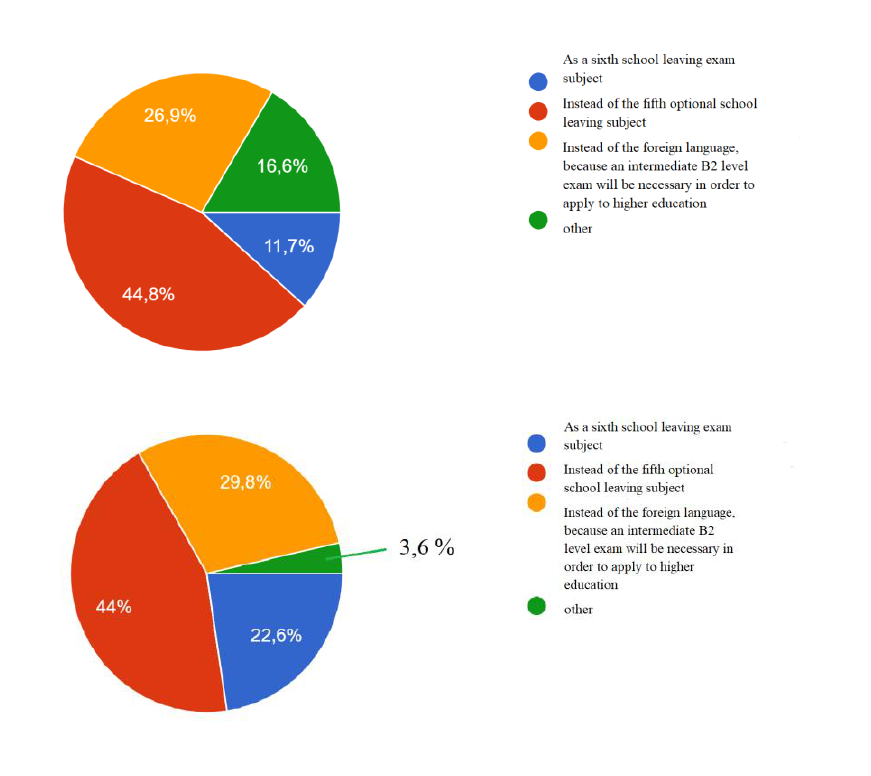
Fig. 4. In what way could you imagine the compulsory natural science subject at the final